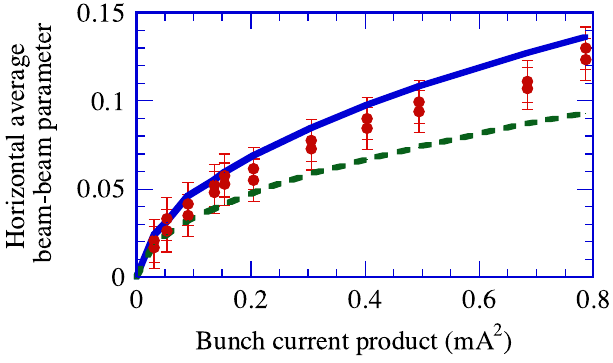
FIG. 10. (Color) The red dots represent horizontal average beam-beam parameter as a function of the product of the bunch currents. The blue solid line represents the horizontal average beam-beam parameter calculated using the beam size consider- ing the dynamic beam-beam effect. The green dashed line is the beam-beam parameter calculated using the nominal beam size. The tune of the H mode is used in the calculation of the dynamic beam size.